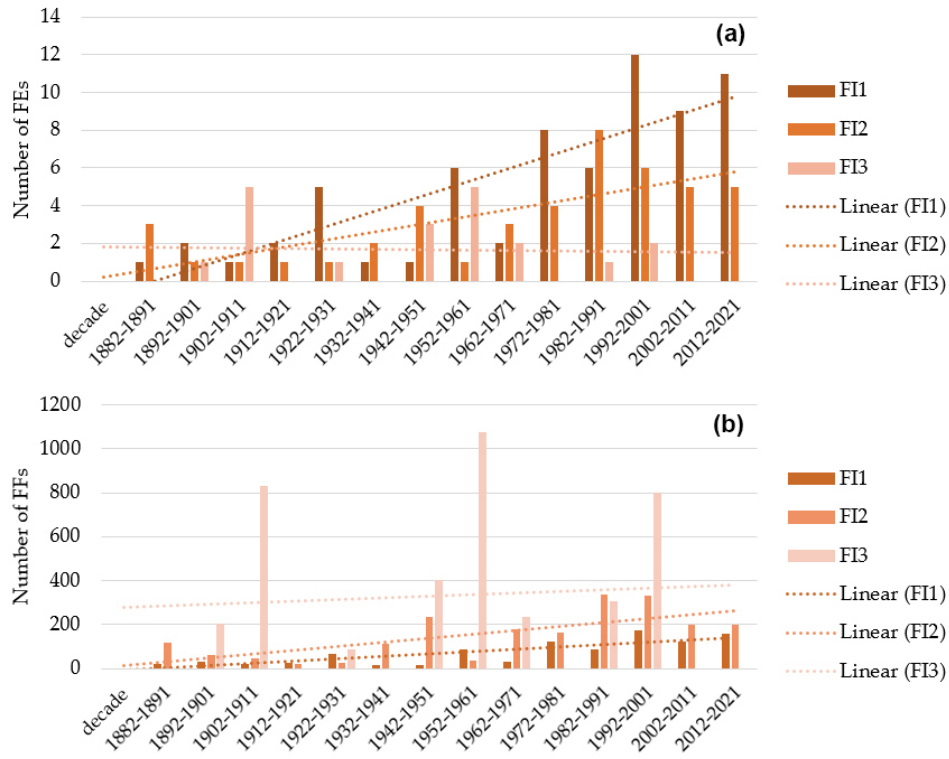
Figure 6. Number of 10-year events, FEs ( a ), and associated fatalities, FFs ( b ), per flood impact magnitude class, FI.